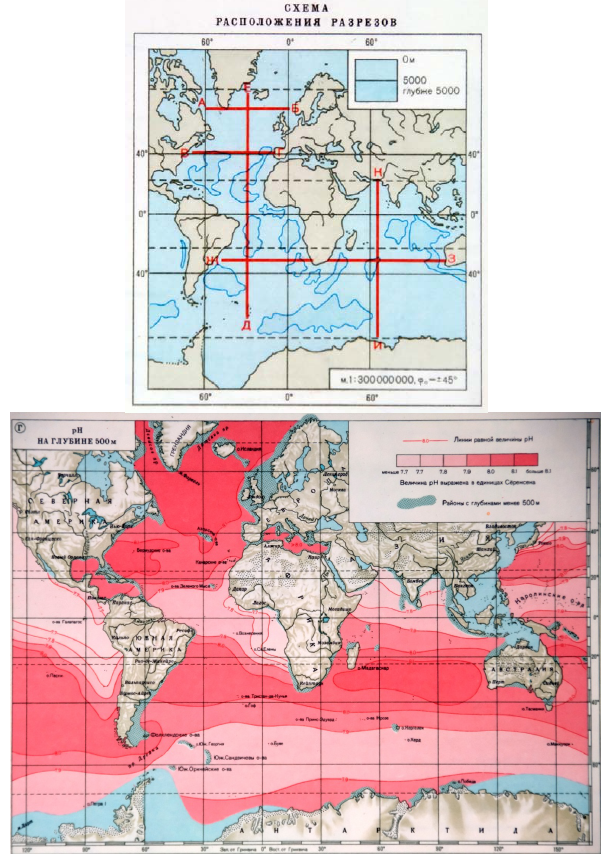
Figure 4. From Gorshkov (1978). The ocean pH survey grid carried out by Soviet scientists in the 1960s (upper panel). And a map of the 500m depth pH field reported (lower panel). The results were contoured in 0.1 pH intervals. US Navy scientists later plotted these data, interpolated the curve, and remarkably then reported the re- sults to ± pH units. This was one of the first snapshots of the large scale ocean pH